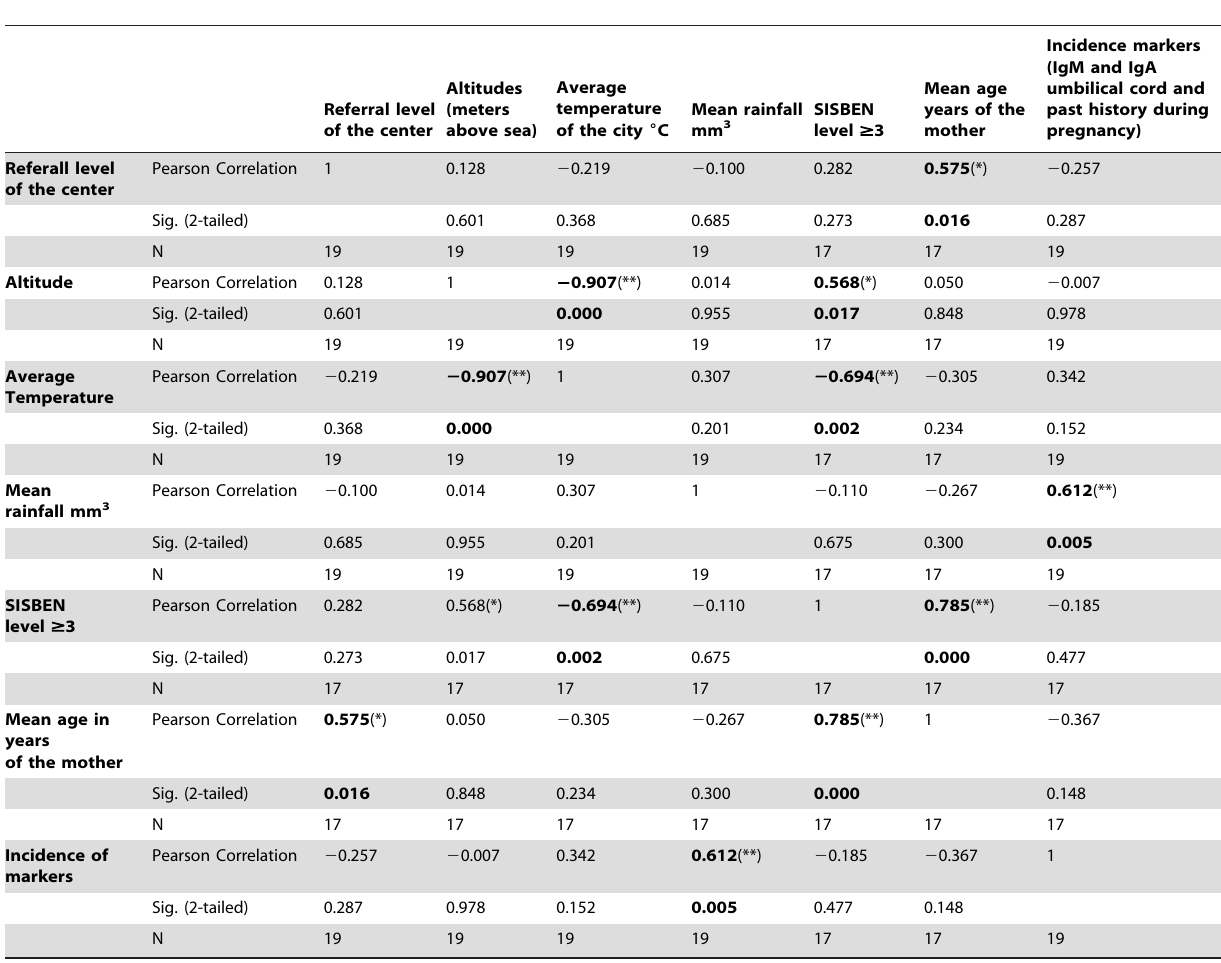
Table 5. Pearson test for correlations at the Colombian multicentric newborn screening for congenital toxoplasmosis.